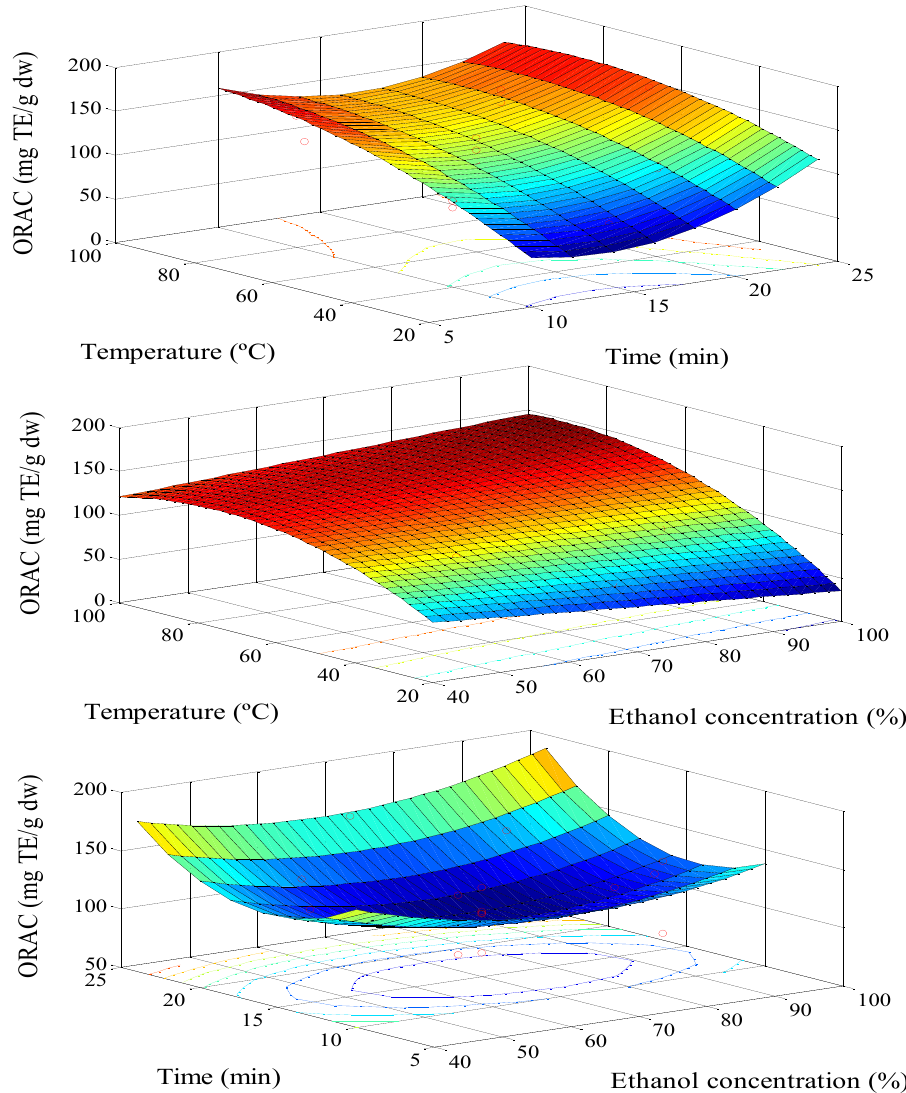
Figure 2. Response surface model plot: the variable is the Oxygen Radical Antioxidant Capacity (ORAC) of the extract. Temperature with time; % EtOH with temperature; % EtOH with